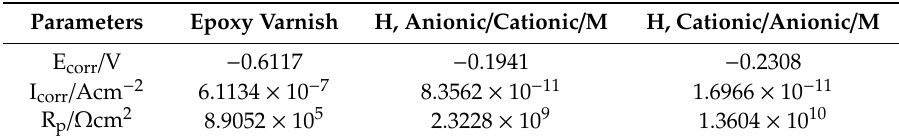
Figure 7. The potentiodynamic polarization curves of different coating systems after being immersed in 3.5 wt. % NaCl aqueous solution for 10 days. Table 3. Fitting results of Q235 steel coated with the bipolar, hydrophobic coatings and the epoxy varnish after 10 days of immersion.